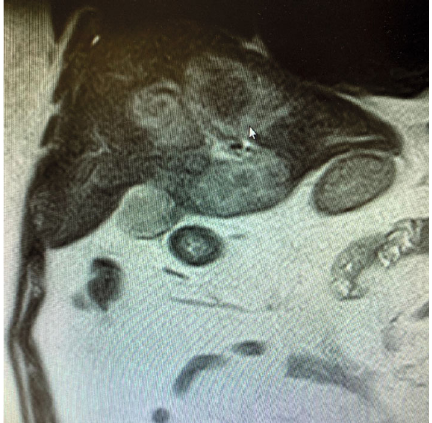
Figure 2: MRI abdomen showing T1 hypointense and T2 heterogeneous hyperintense thin-walled peripheral rim enhancing and intercommunicating cystic mass measuring predominately involving segments IV a, IV b, and